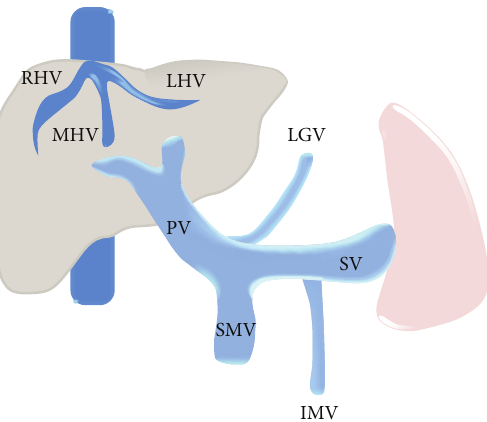
Figure 1: Graphic illustration of the splanchnic venous system. RHV: right hepatic vein, MHV: middle hepatic vein, LHV: left hepatic vein, PV: portal vein, SMV: superior mesenteric vein, SV: splenic vein, LGV: left gastric vein, and IMV: inferior mesenteric vein.